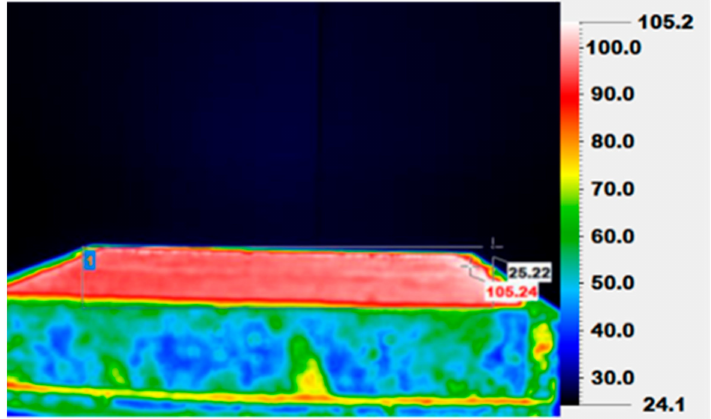
Figure 2. Thermal image of an asphalt